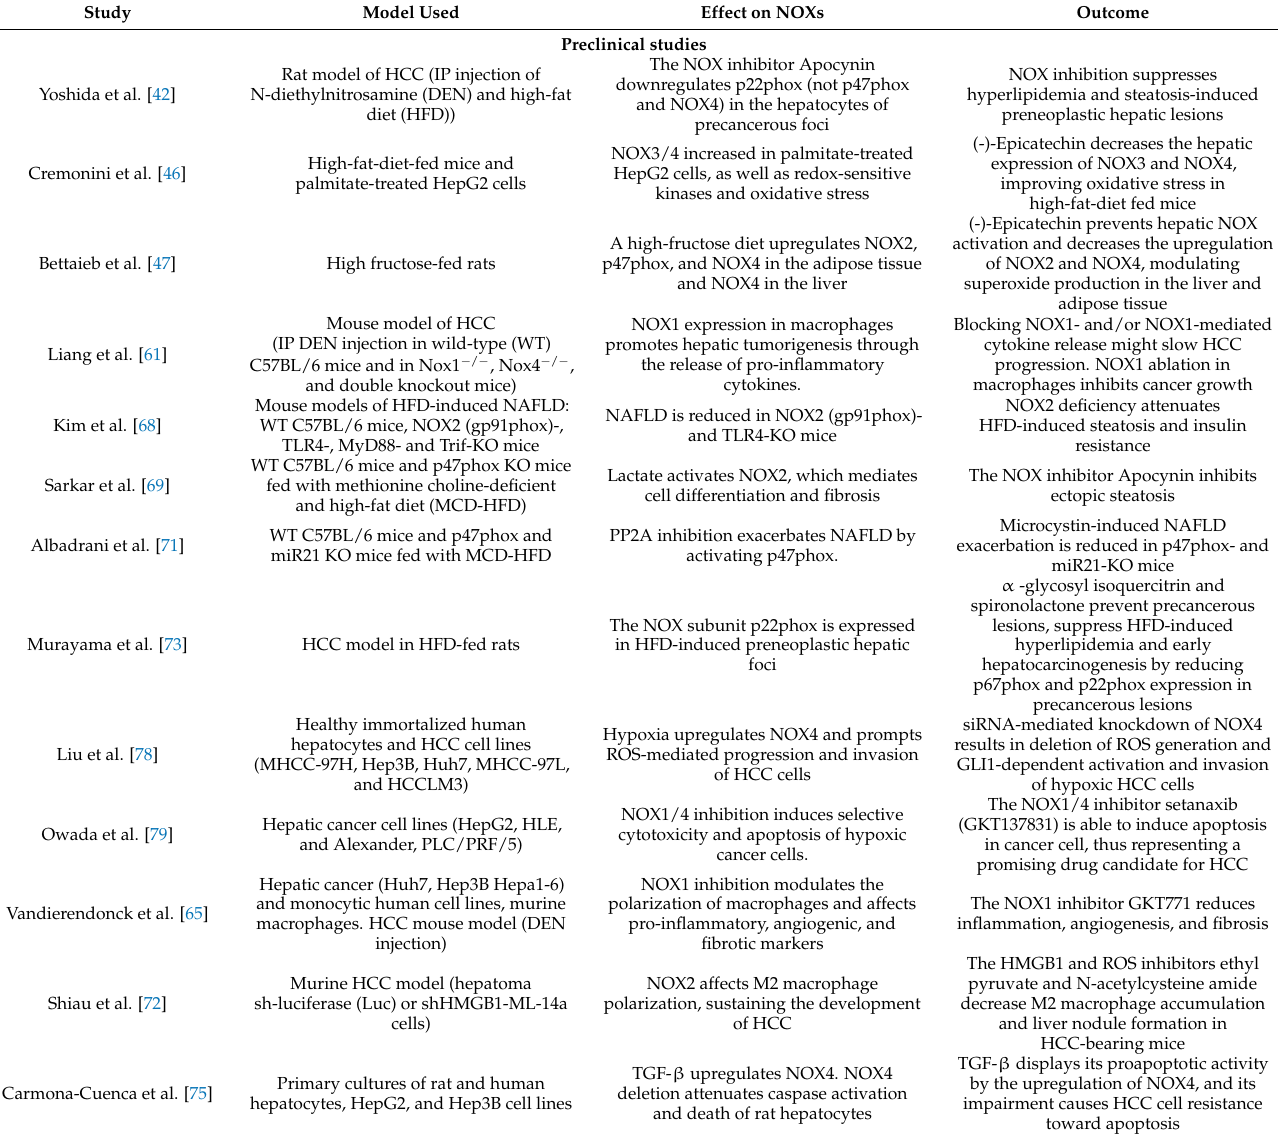
Table 1. Preclinical and clinical evidence of the link between modification of NOX expression and activity and oxidative stress in NAFLD, NASH, and